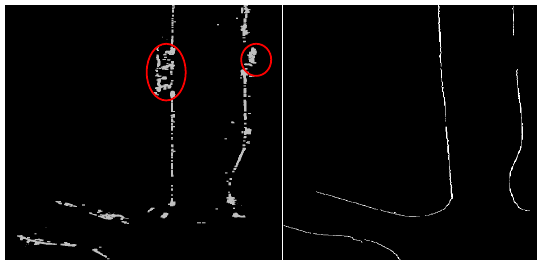
Figure 14. The extracted road curb. Left: From 3D approach. Right: From 2D